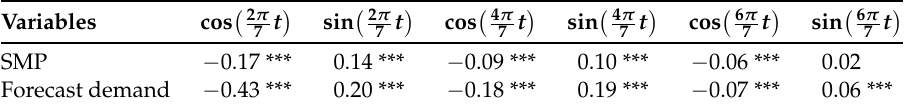
Table A3. Correlation of the SMP and the forecast demand with periodic